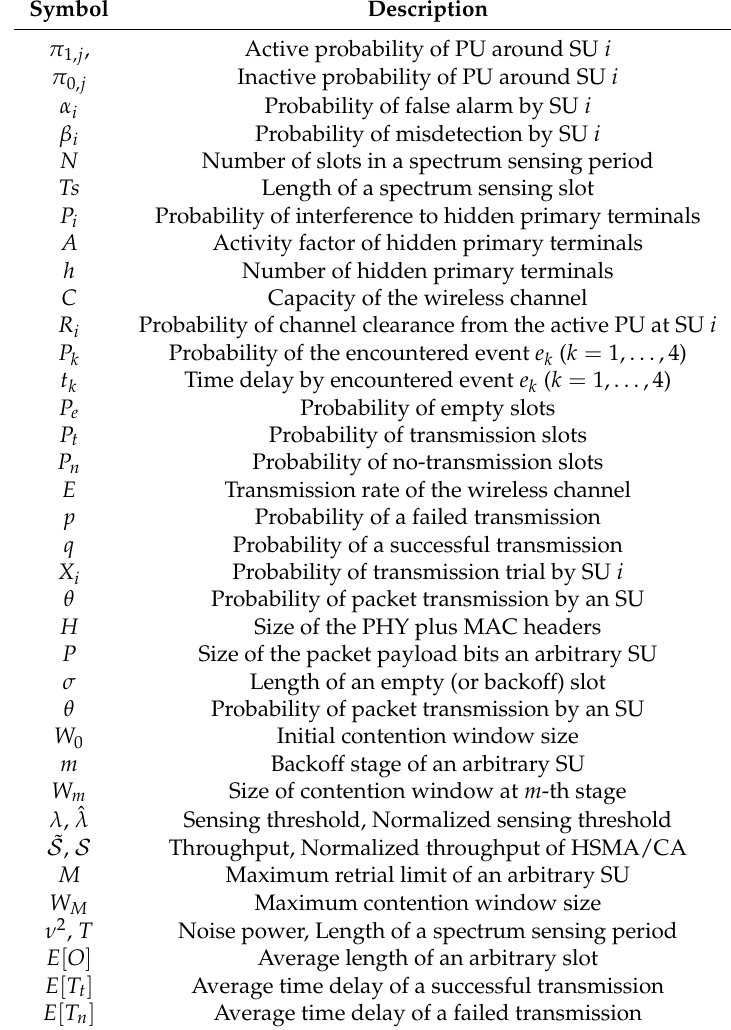
Table 1. Summary of the